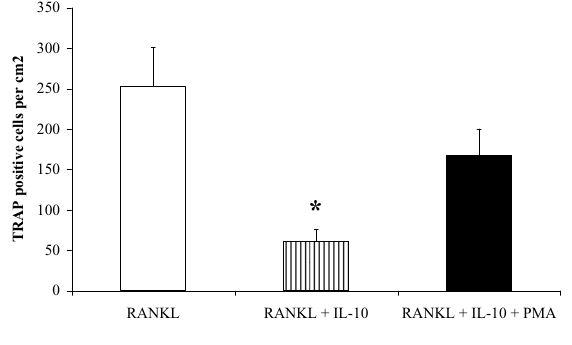
Quantitative RT-PCR analysis of NFATc1 mRNA expression in RAW264.7 cells. Cultures were treated with RANKL, RANKL and IL-10 or RANKL, IL-10 and PMA for 24 hours and total RNA extracted. Quantitative PCR was performed on a Techne Quantica PCR machine using the DNA binding dye SYBR-green and specific primers for murine NFATc1 and β -actin. For each sample the NFATc1 copy number was expressed as the relative copy number normalised to 10 6 β -actin copies. Samples were analysed in triplicate and are expressed as the mean of three separate experiments. * p < 0.05 versus RANKL